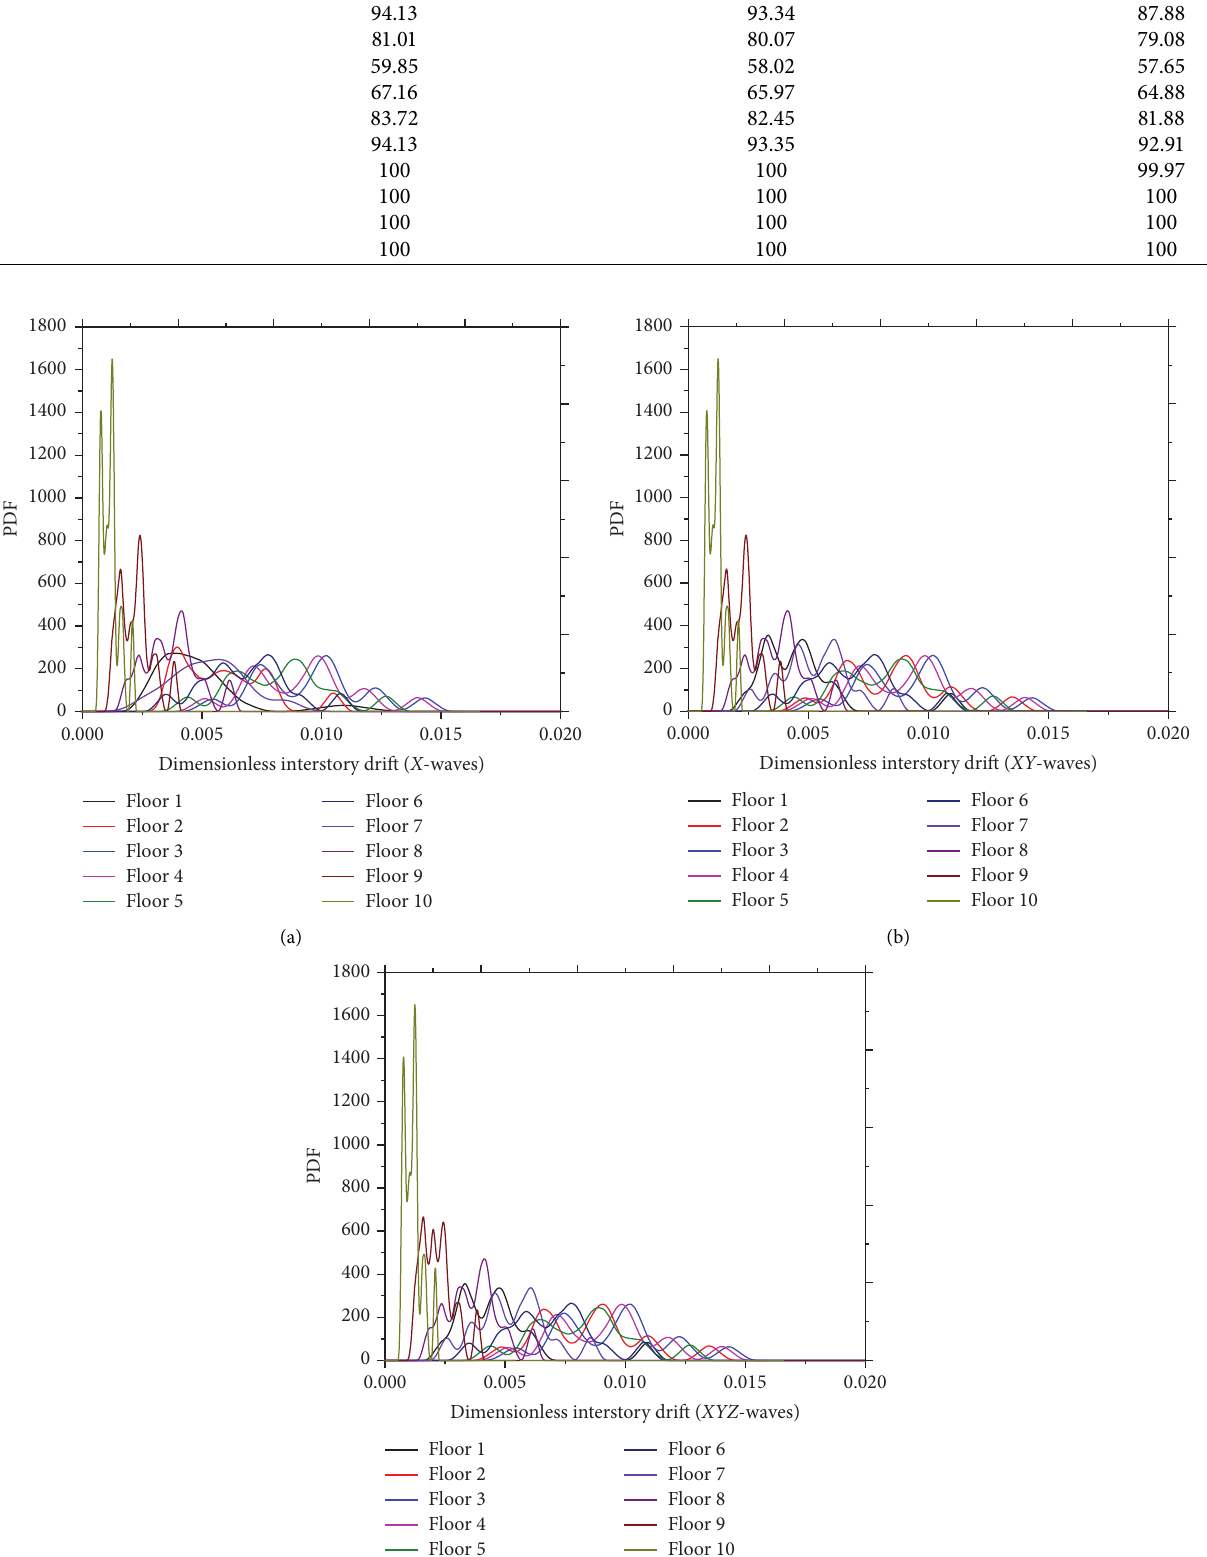
Table 2: Reliability results for the 10-story building structure.